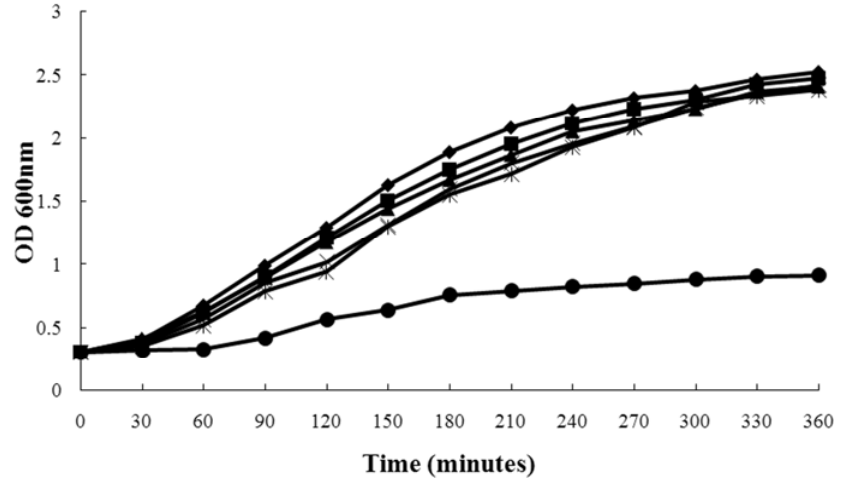
Figure 1. Growth curves of S. aureus strain ATCC 29213 treated with different concentrations of allicin. ( ◆ ), untreated S. aureus ; ( ■ ), S. aureus plus allicin at 2 μ g/mL; ( ▲ ), S. aureus plus allicin at 4 μ g/mL; (×), S. aureus plus allicin at 8 μ g/mL; and